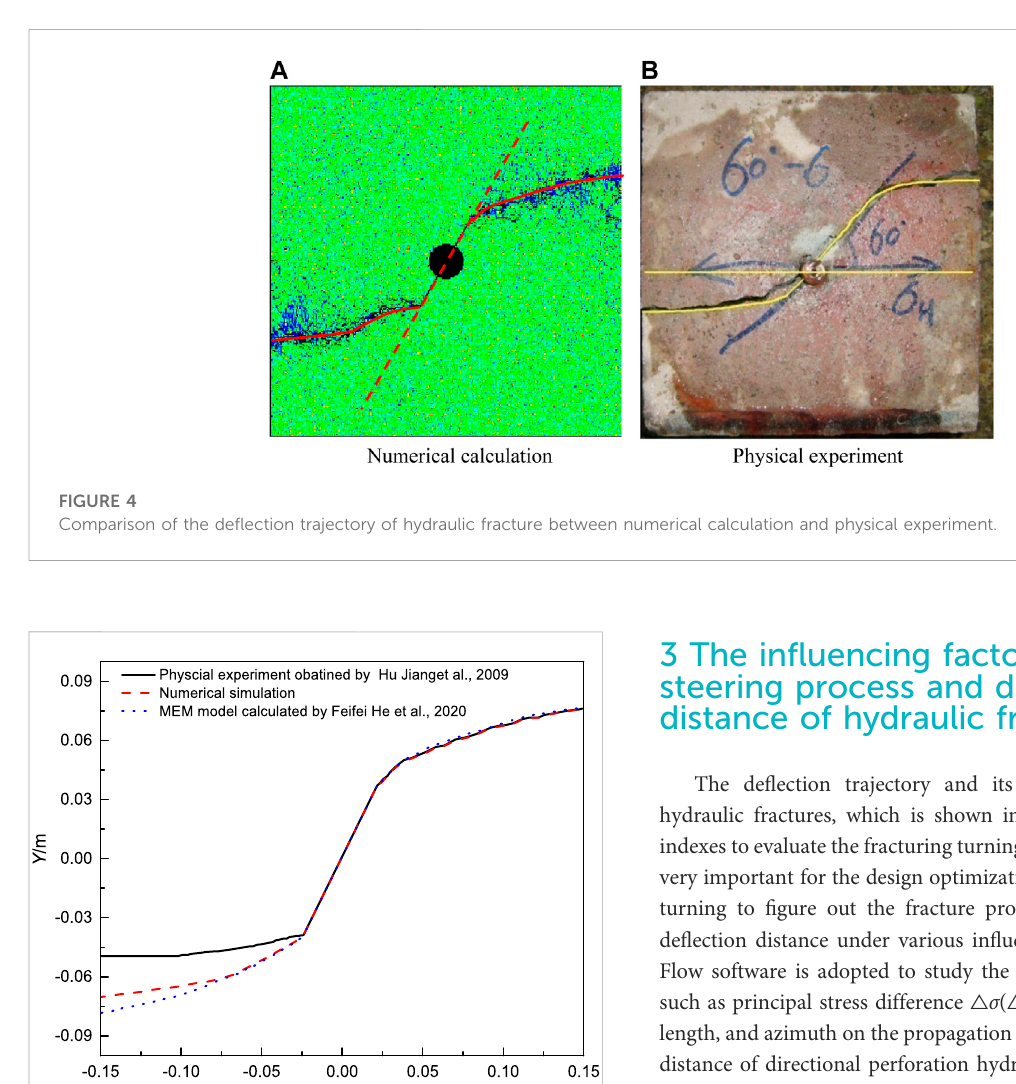
FIGURE 5 Comparison of results calculated using RFPA 2D -Flow software, laboratory test, and the MEM